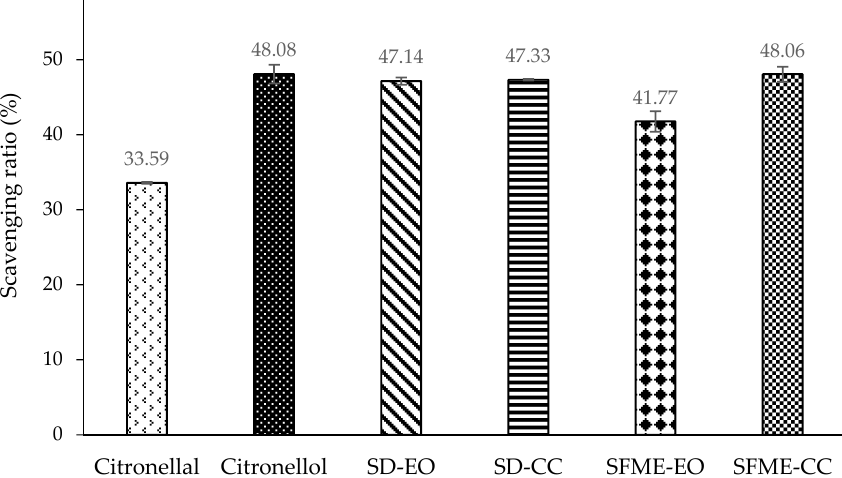
Figure 2. Diphenyl-1-picrylhydrazyl (DPPH) radical scavenging ratio (%) of ‘Mato Peiyu’ leaf essential oils, citronellal, and citronellol. SD-EO, SFME-EO, citronellal, and citronellol were measured at a concentration of 0.500% ( v / v ). SD-CC and SFME-CC were measured at concentrations of 0.254% and 0.299% ( v / v ) according to the composition ratios in 0.500% ( v / v ) SD-EO and SFME-EO, respectively. Data are presented as the mean ± standard deviation based on triplicate determination.